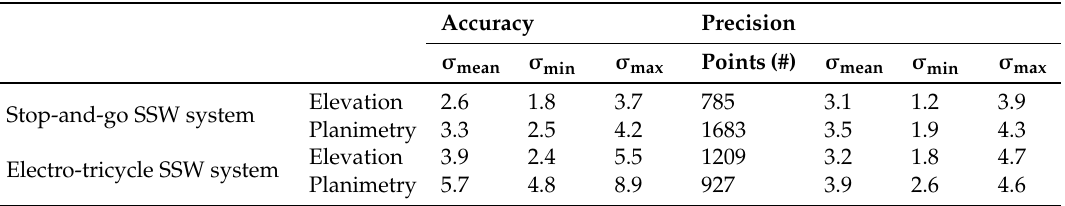
Table 3. Accuracy and precision of SSW laser scanner in Planimetry and elevation